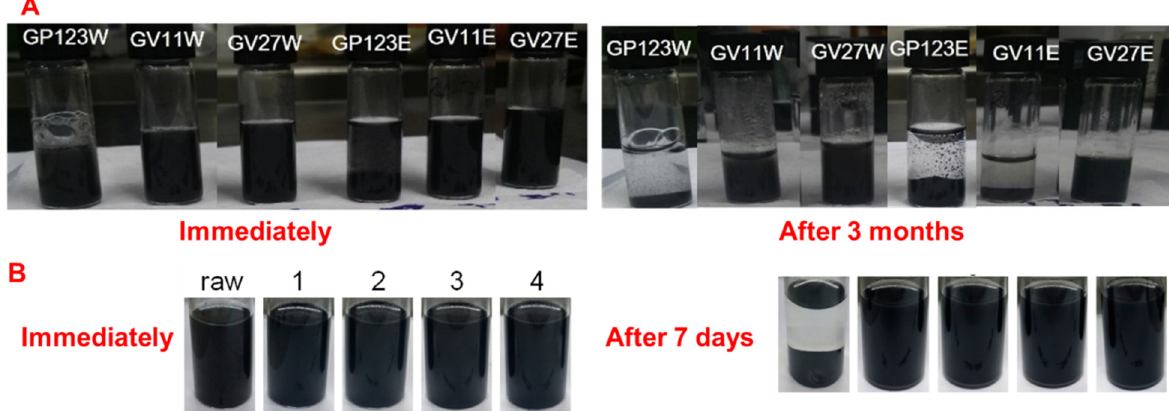
Figure 7. Photographic images of graphene dispersions using PVP-b-PEO in aqueous and EtOH ( A ) and using PTFEMA- b-PVP in MeOH ( B ). ( A ) is reproduced from ref. [113] with permission and ( B ) is reproduced from ref. [118]. G: graphite; P123: P-123 surfactant; W: aqueous medium; E: EtOH medium; V11: PVP(11k)-b-PEO(10k); 27: PVP(27k)-b-PEO(10k); raw: graphite; 1: PTFEMA(11k)-b-PVP(4k); 2: PTFEMA (11k)-b-PVP(21k); 3: PTFEMA(22k)-b-PVP(3k); 4: PTFEMA (22k)-b- PVP(20k).